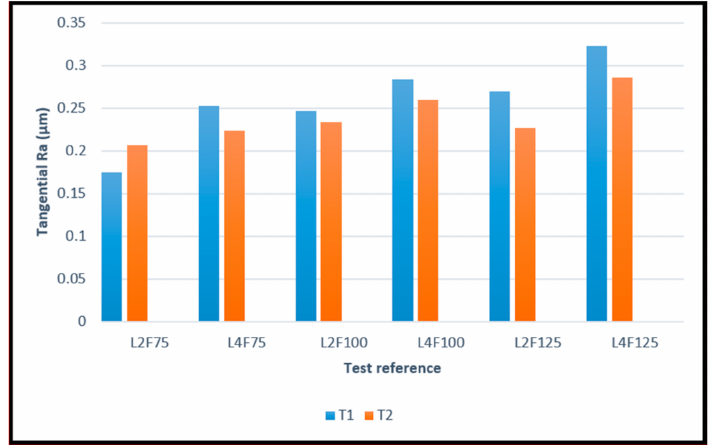
Figure 3. Average values of Ra, measured in the tangential direction, produced by T1 and T2 tools for all the different test conditions.